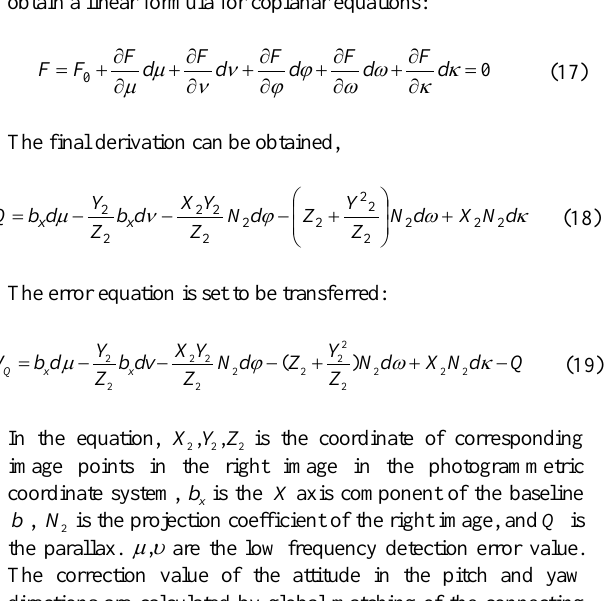
Figure 3. Relative orientation